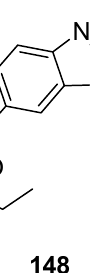
Figure 31. Antifungal benzo[1,2,3]thiadiazole-7-carboxylate derivative 148 .